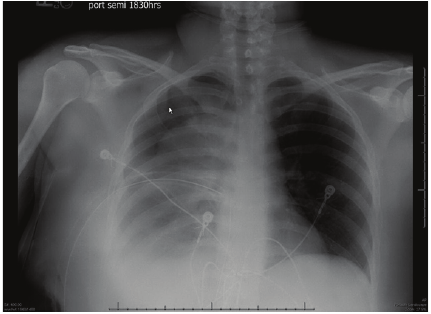
Figure 2: Chest X-ray obtained at trauma center showing persistent hemothorax despite chest tube placement at outside